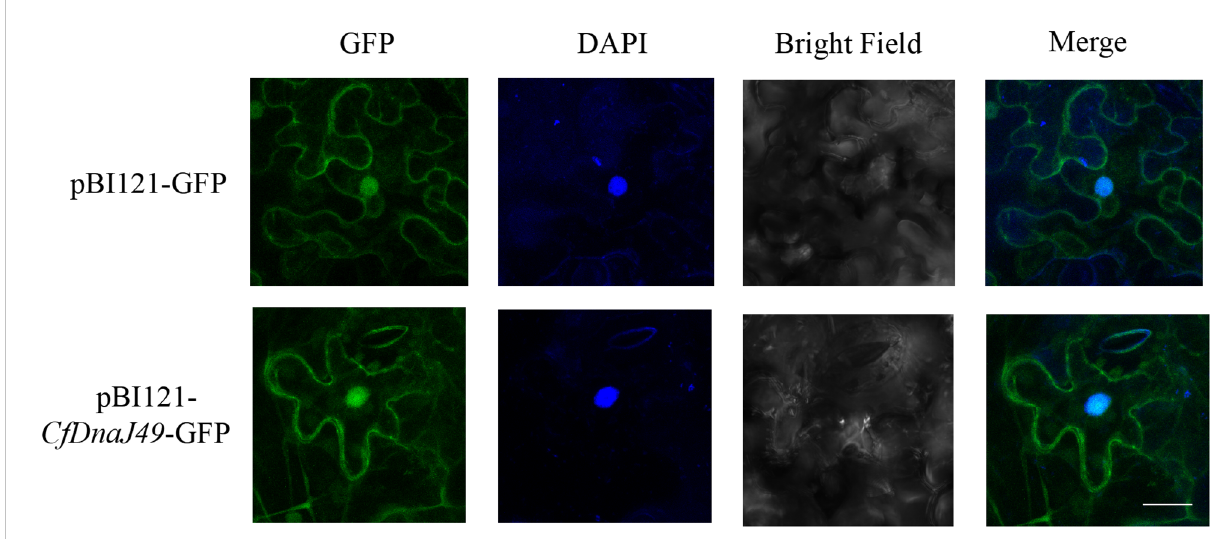
FIGURE 6 Subcellular localization of CbuDnaJ49. The length of white bar represents 10 um.